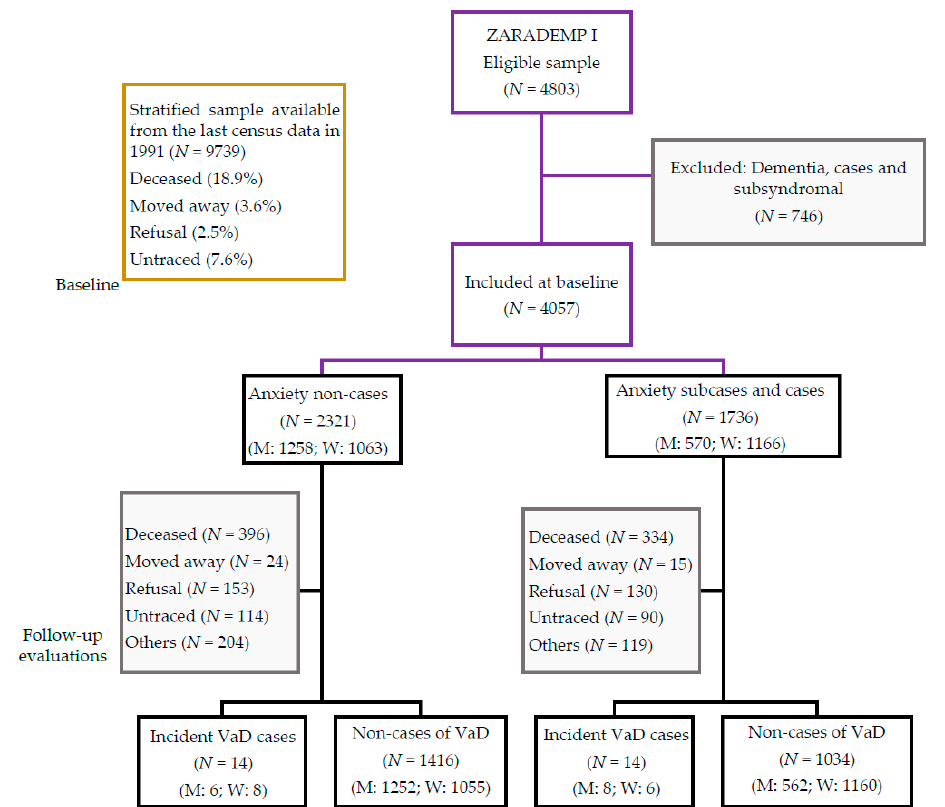
Figure 1. Zaragoza Dementia and Depression Project (ZARADEMP) study flow chart . Notes: M: men; W: women. VaD: vascular dementia. W: women. VaD: vascular